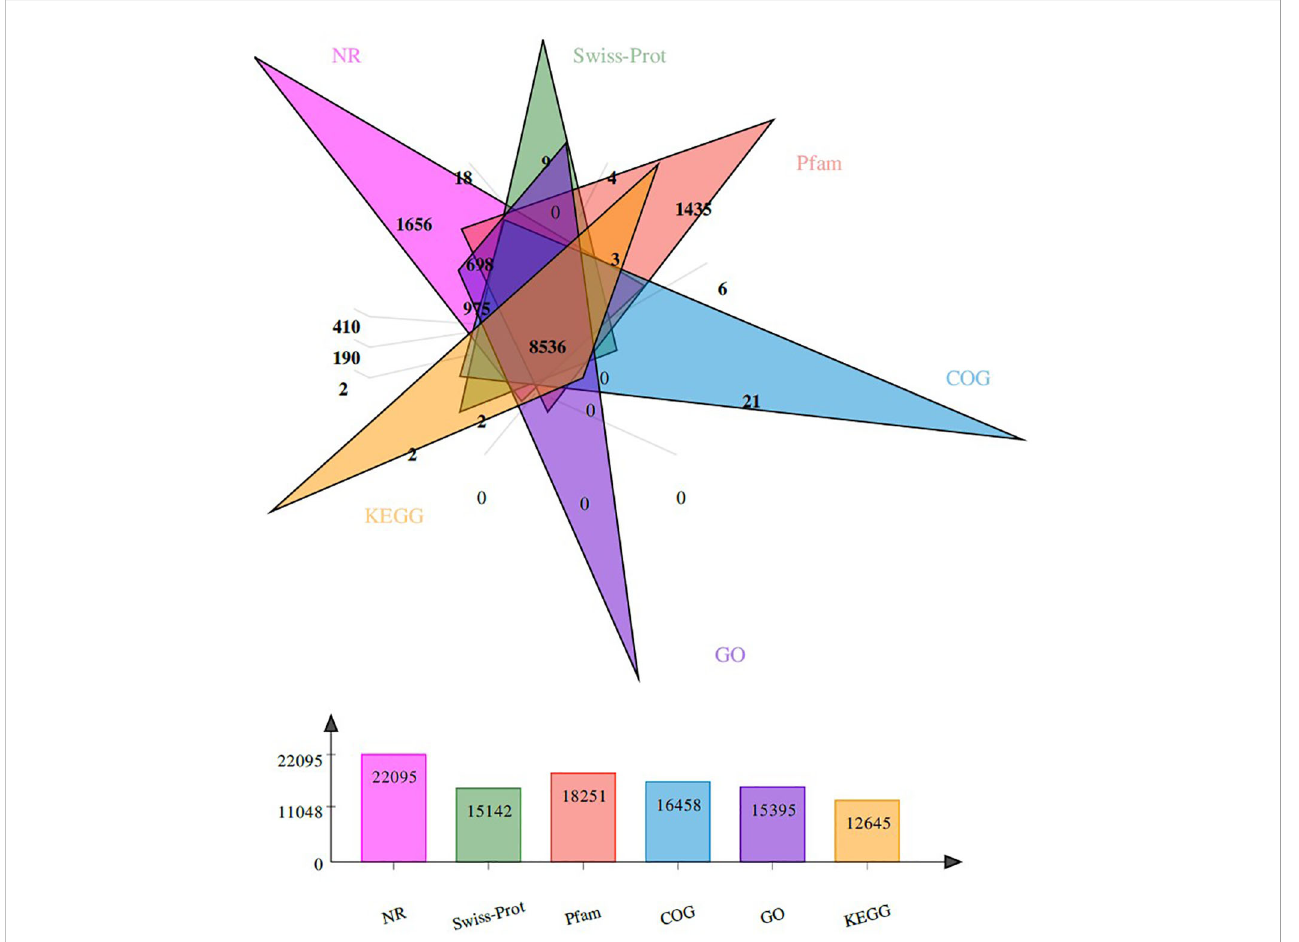
FIGURE 2 The distribution of unigenes in six databases. The colors show different databases. The number represents the total number of